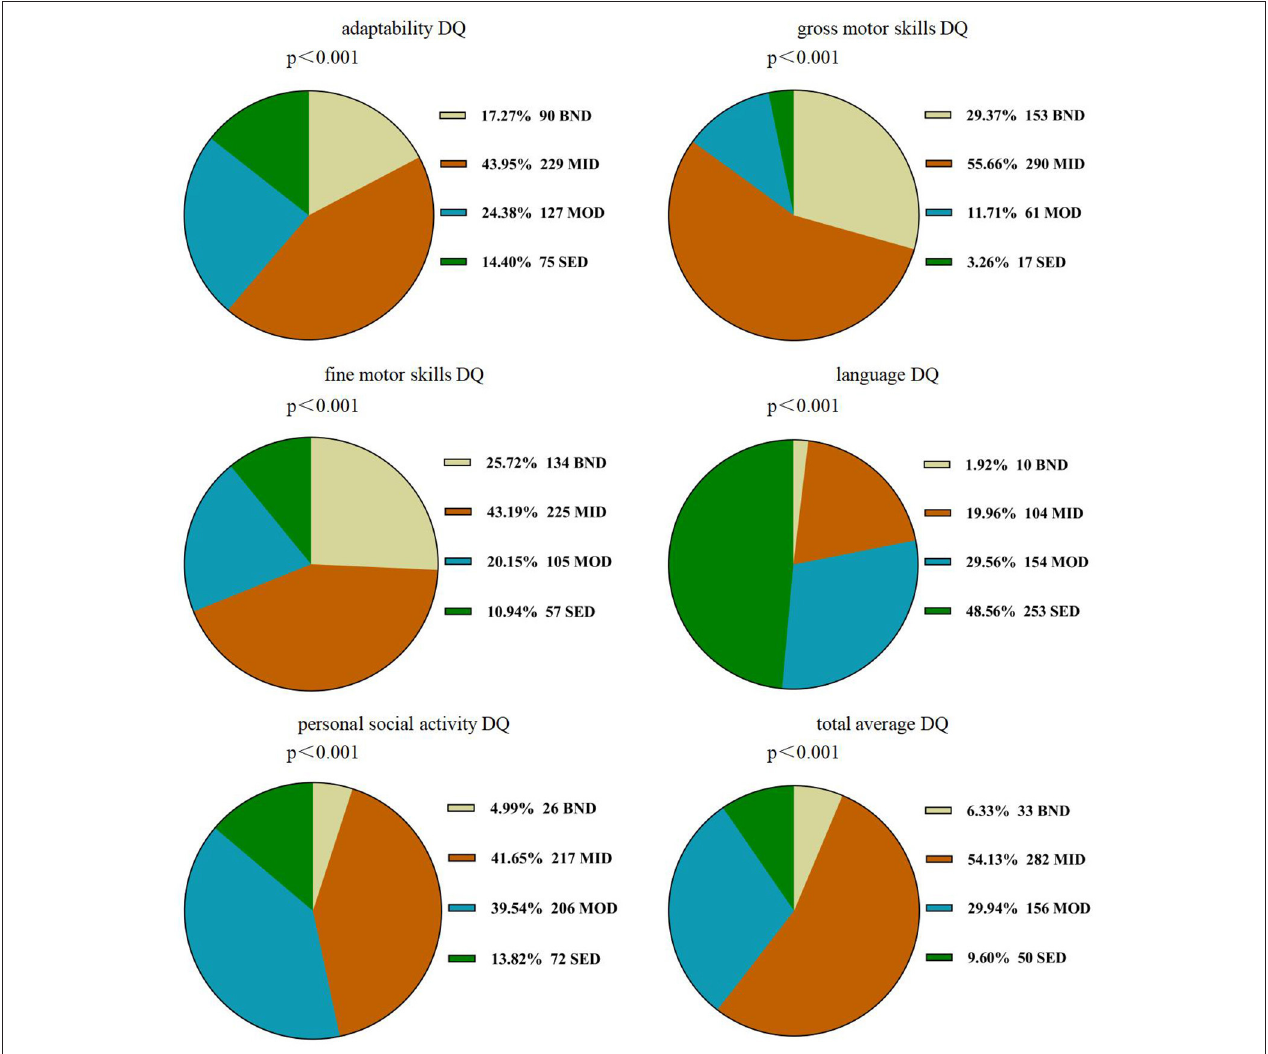
FIGURE 2 | Distribution of DQ scores of GDS in children with GDD. GDD, Global developmental delay; DQ, developmental quotient; GDS, the Gesell Developmental Schedules; BND, borderline-normal defect; MID, mild defect; MOD, moderate defect; SED, severe and extremely severe